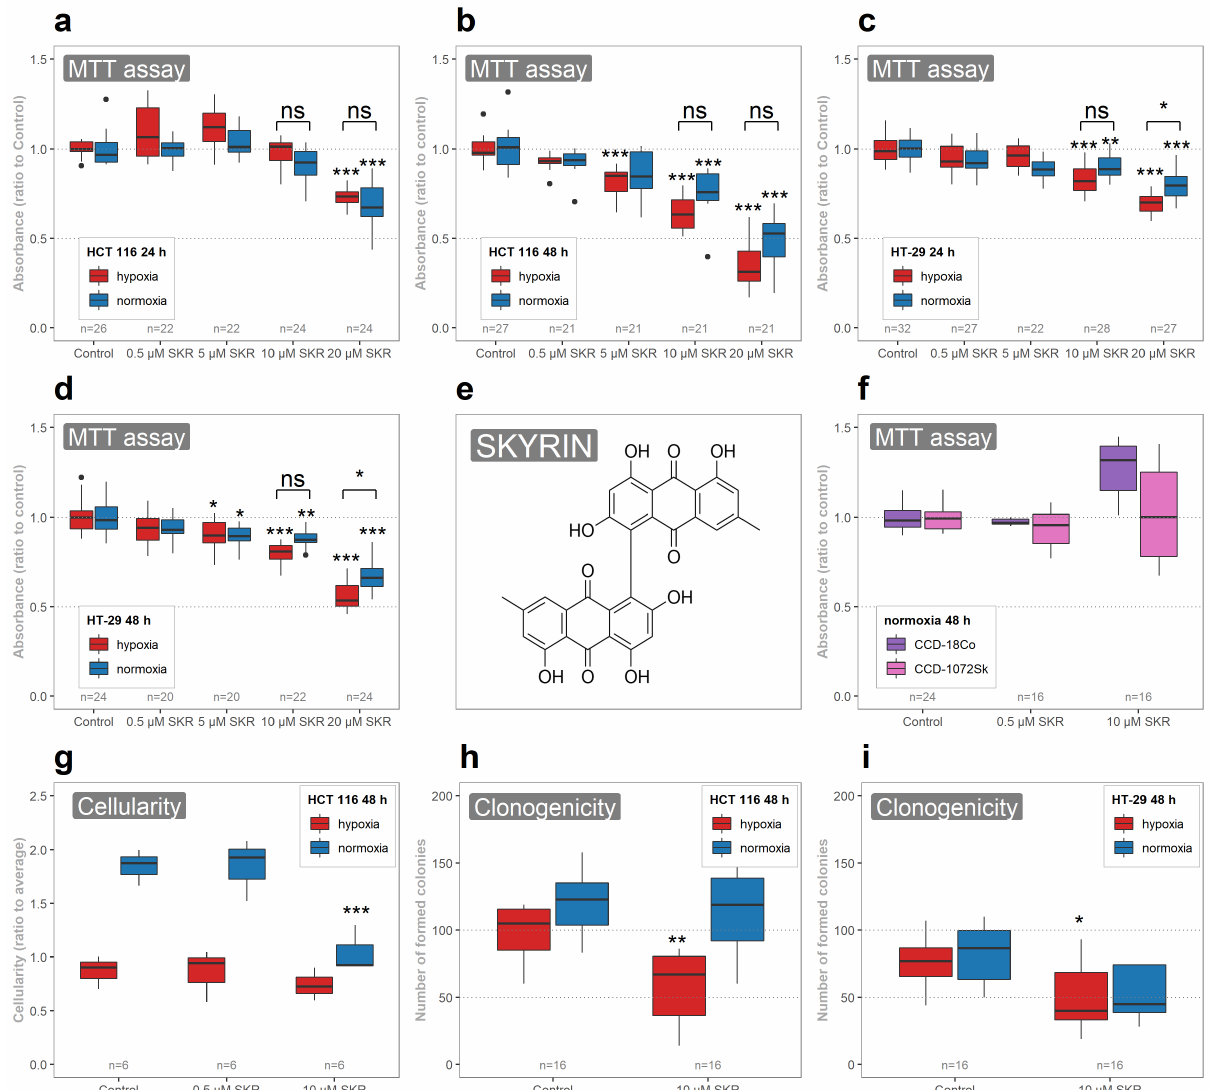
Figure 1. The effect of SKR on the basic cellular parameters of normal and cancer cell lines. ( a – e ) SKR significantly decreases the metabolic activity of both cancer cell lines, with the most prominent effect in HCT 116 cells, but with no effect on healthy cells. ( a , b ) In cancer cell line HCT 116, there was a significant effect after treatment with SKR, as observed in the 5 µ M concentration of SKR in hypoxic conditions and 10 µ M concentration of SKR in normoxic conditions after 48 h. ( c , d ) In HT-29 cells, the effect of SKR on metabolic activity was significant in higher concentrations, as observed in HCT 116 cell line. ( e ) Molecule of skyrin (SKR). ( f ) SKR has no negative effect on the metabolic activity of pathologically unchanged cell lines in used concentrations. ( g ) The relative cellularity in treated samples of HCT 116 cell line in normoxia was significantly decreased, approximately to the levels of untreated cells in hypoxia. There were no significant changes in the cellularity of HCT 116 cell line after the treatment with SKR in hypoxia. ( h , i ) The clonogenicity of SKR treated cells was not increased towards the untreated samples. The results are expressed as boxplots of at least three independent experiments. The experimental groups were compared with the matching control group in the same condition (e.g., hypoxic control or normoxic control). The number of samples (n) is noted in plots. Comparison between hypoxia and normoxia samples is denoted over the compared samples (* p < 0.05, ** p < 0.01, *** p < 0.001), ns—not